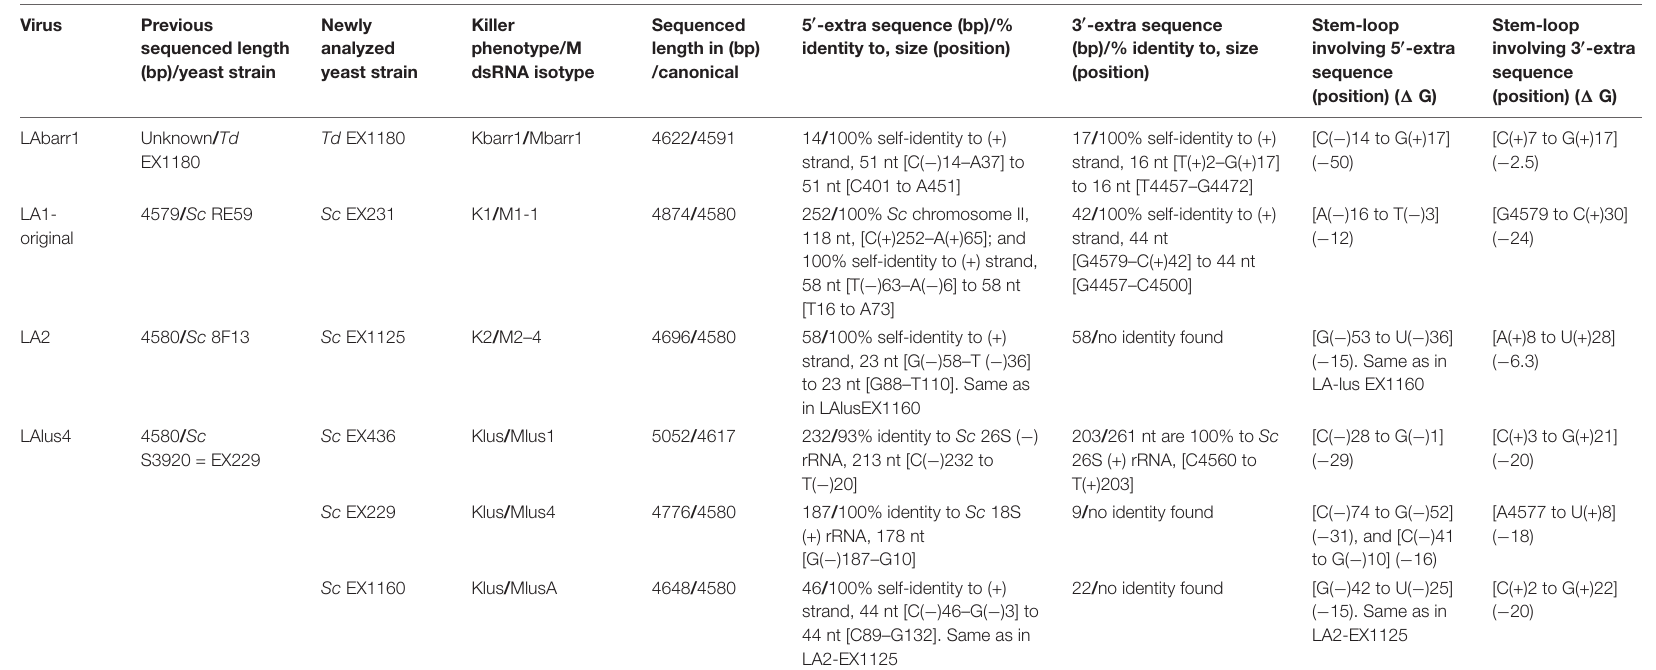
TABLE 3 | Characteristics of dsRNA LA-virus genomes sequenced by HTS.